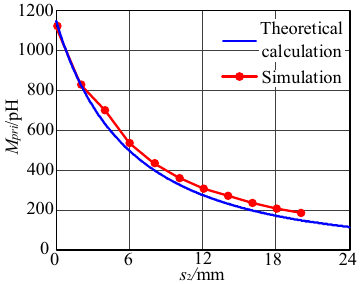
Figure 21. Mutual inductance M between two loops varies with s 2